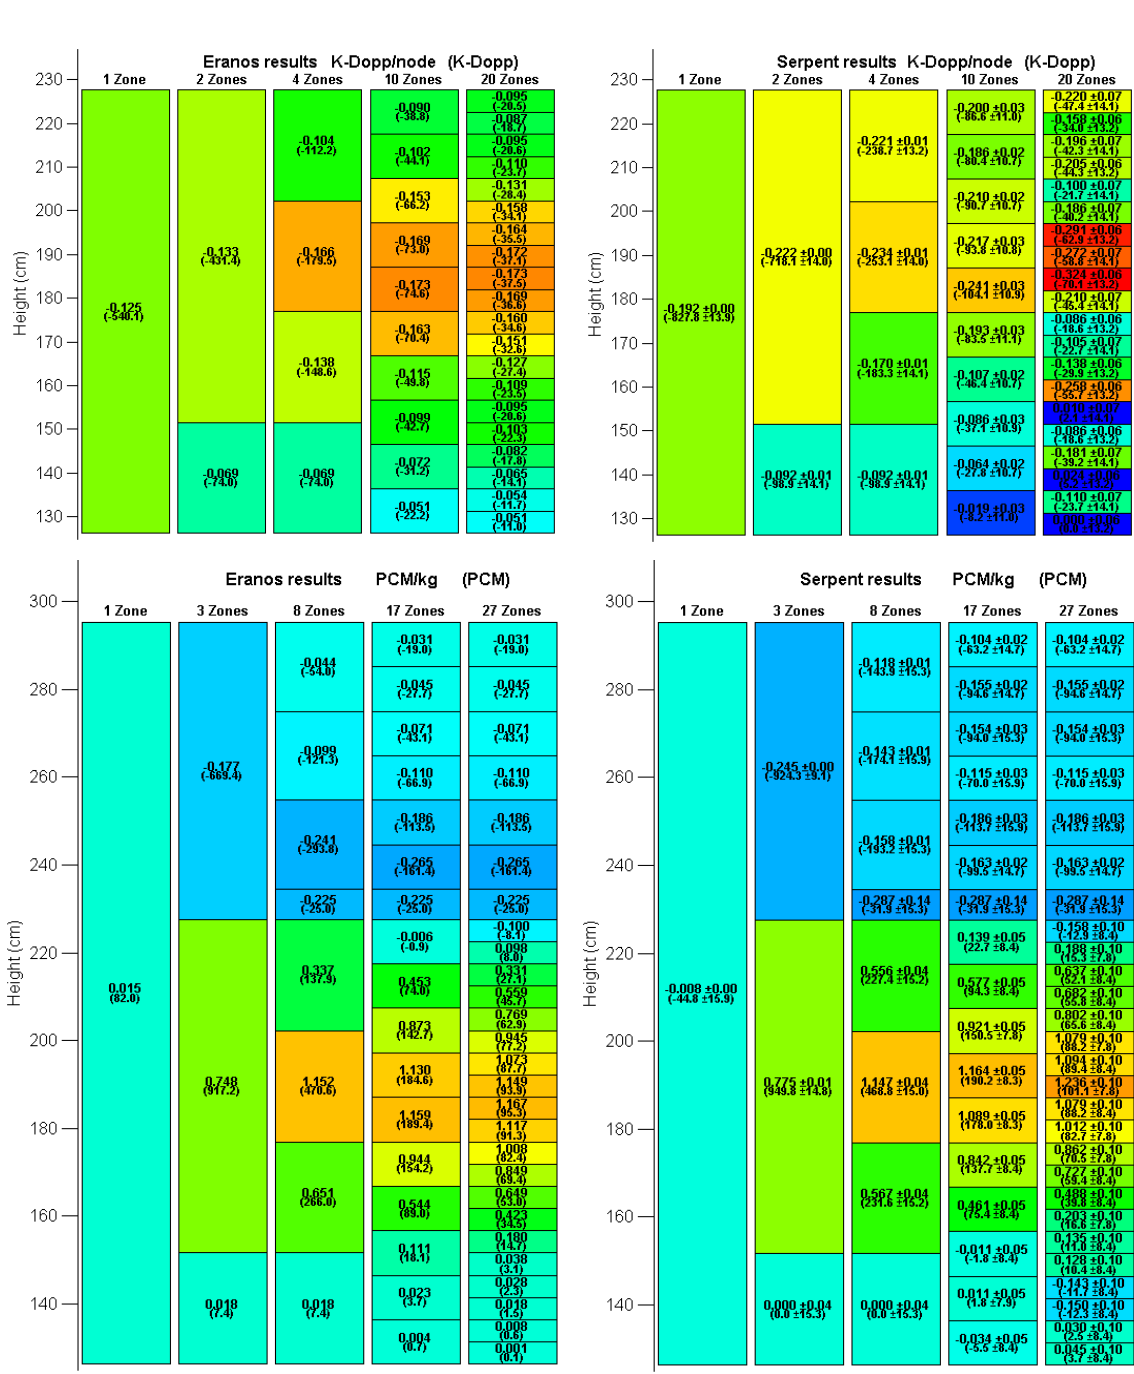
Figure 4. Doppler constant (top) and void reactivity (bottom) mapping using the full core ERANOS model (left) and the radially infinite Serpent model